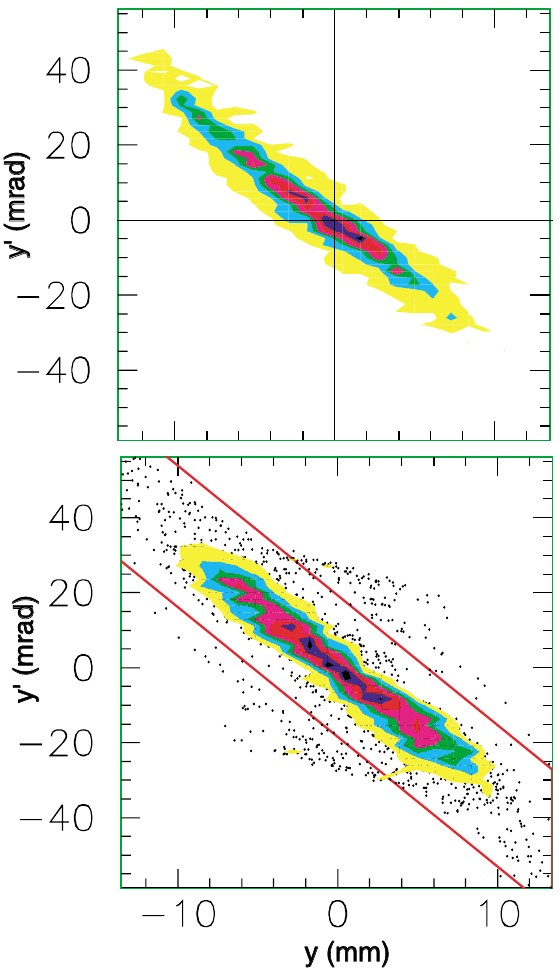
FIG. 8. (Color) Experimentally measured vertical phase space (top panel) versus PIC (bottom panel) at d 5 . The red box indicates for the simulation the region inside of which particles were included for the PIC (88%) emittance calculations of Table II. The contour lines indicate 12.5% increments in relative intensity, and the color code sequence from lowest to highest intensity is yellow, . . . black. All of the PIC particles that lie outside of the lowest contour level are shown in order to illustrate the details of the calculated halo.